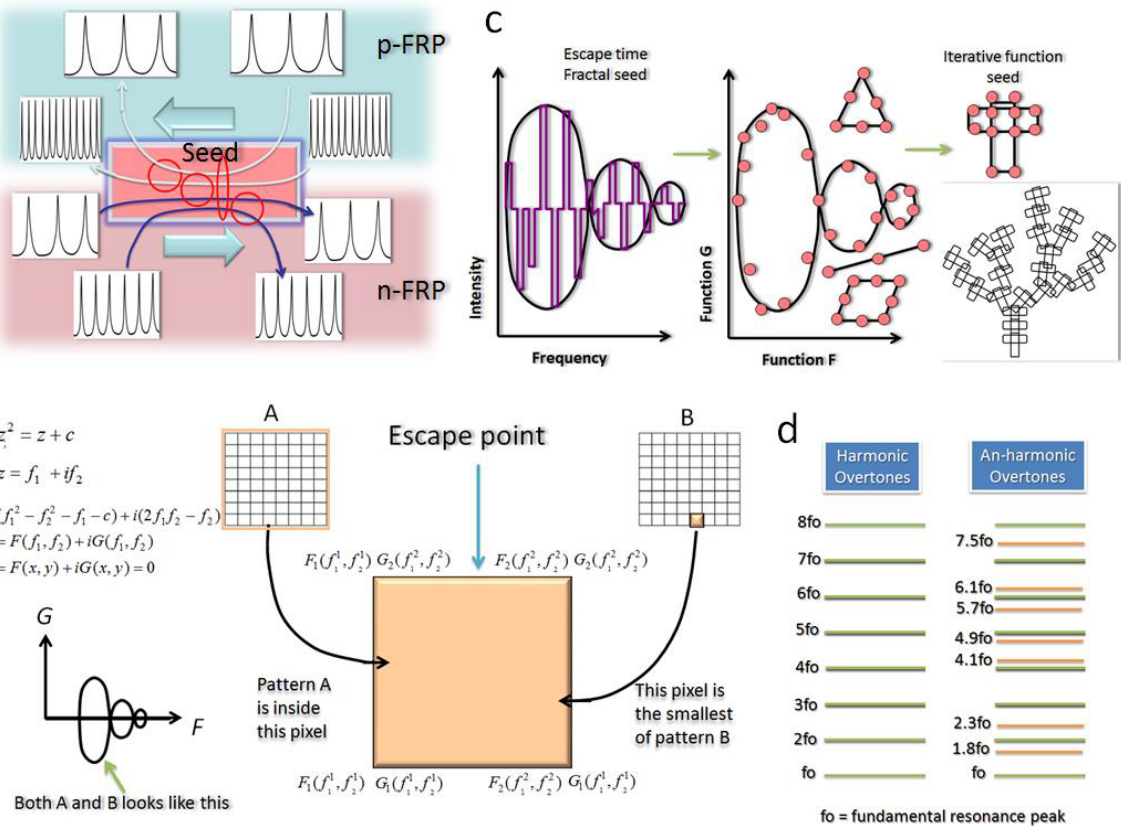
Figure 6. ( a ) Signals propagating in an opposite direction in a seed oscillator; ( b ) Escape point hardware means a given layer is a single cell of another layer B and at the same time has enormous seeds A inside; ( c ) Escape time hardware, produces basic geometric fractal seeds; ( d ) Harmonic and anharmonic overtones, one is integral multiple and another is non-integral, there are infinite